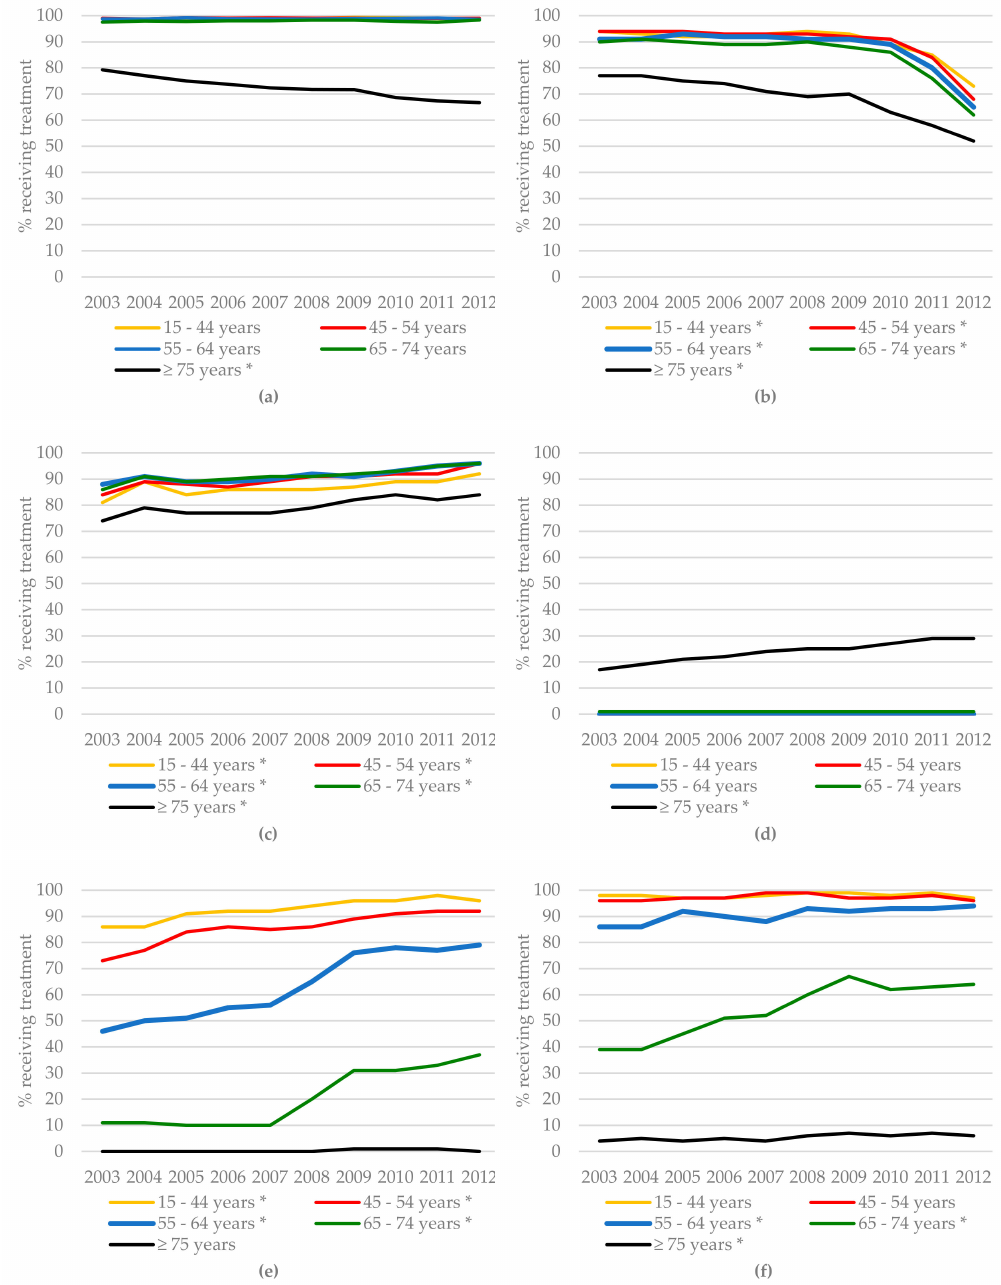
Figure 2. Time trends in the treatment of breast cancer (BC) patients according to age group: ( a ) surgery in BC patients stages I–III, ( b ) lymph node dissection in BC patients stages I–III with node-positive disease, ( c ) radiotherapy after breast-conserving surgery in BC patients stages I–III, ( d ) primary endocrine therapy in BC patients stages I–III, ( e ) chemotherapy in BC patients stage II, and ( f ) chemotherapy in BC patients stage III. * Significant ( p < 0.05) di ff erence in treatment over time using the Cochran–Armitage trend